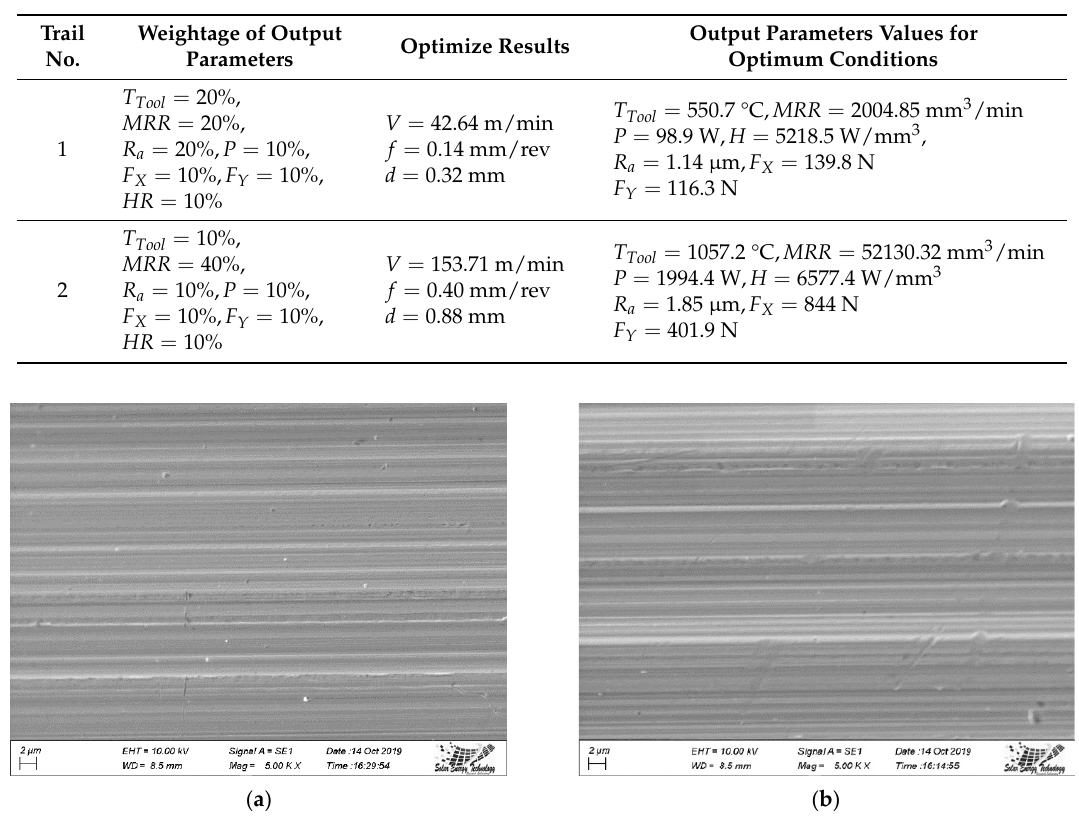
Figure 4. SEM image at optimum cutting condition × 5000 magnification at optimization in ( a ) Trail 1 ( b ) Trial 2.